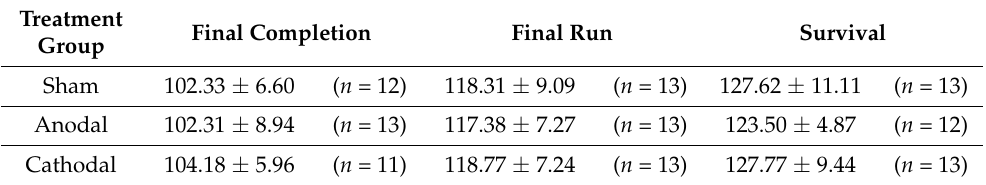
Table 2. Averages with standard deviation for first failure (onset of motor function degeneration),